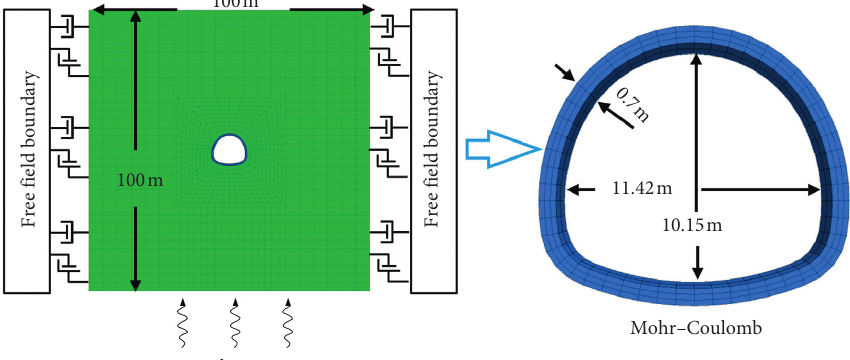
Figure 2: Calculation model of Zheduoshan tunnel.